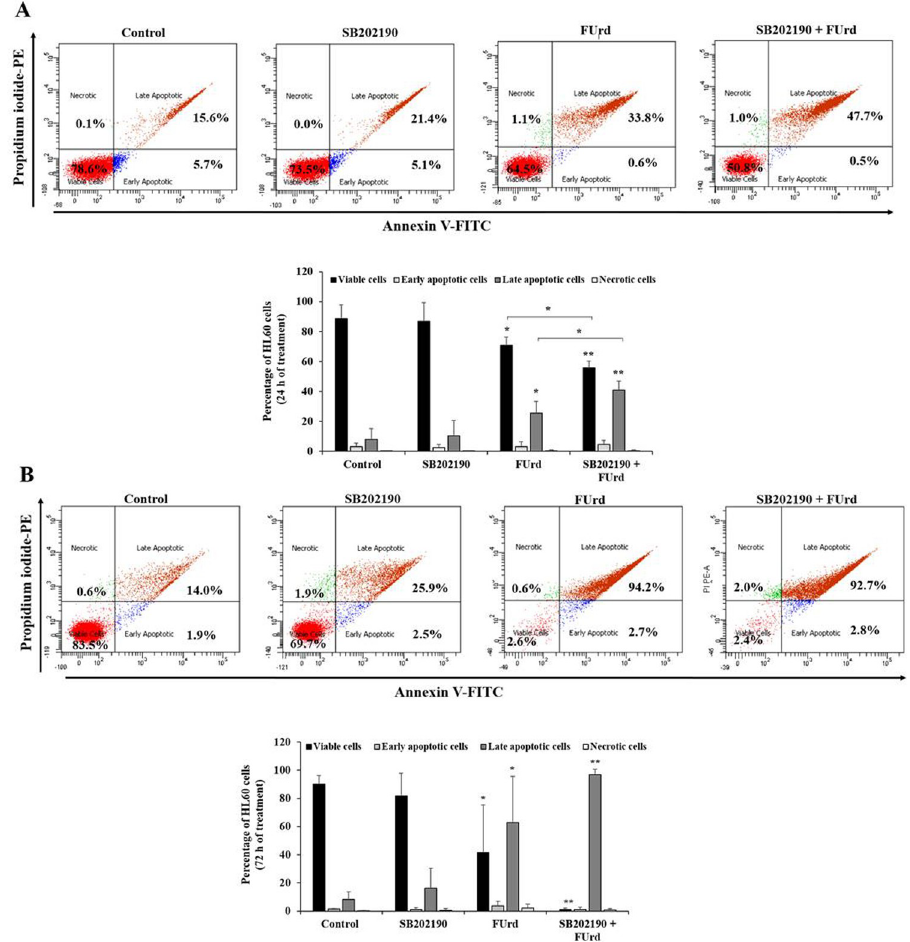
Fig 4. Analysis of apoptotic status in HL60 cells in response to 24-h (A) and 72-h (B) treatment with FUrd after cell pretreatment with SB202190. The HL60 cells were non-treated, treated with pharmacological inhibitors for 2 h incubation prior to cell treatment with 10 μ M of FUrd. After 24 h (A) and 72 h (B) incubation, the cells underwent FITC-labeled Annexin V/PE-labeled PI double-staining for apoptosis analysis using FACS. The numbers within the scatter plots represent the percentage of viable (lower left, Annexin V - /PI - ), early apoptotic (lower right, Annexin V + / PI - ), late apoptotic (upper right, Annexin V + /PI + ), and necrotic cells (upper left, Annexin V - /PI + ). The bar graphs present the percentage viable, early apoptosis, late apoptosis and necrosis of the SB202190-pretreated HL60 cells in the presence or absence of 10 μ M FUrd along with the non-treated (control) cells, based on three independent experiments. The results are presented as mean ± SD. � p < 0.05, �� p < 0.01, and ���� p < 0.0001 vs .